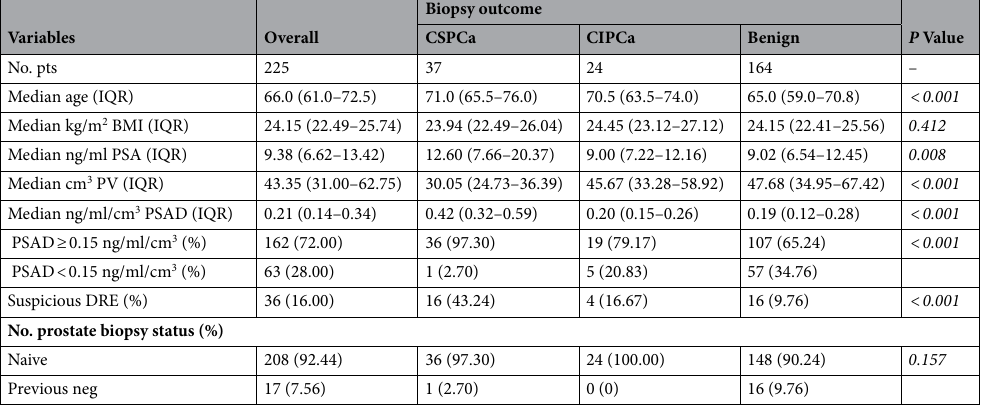
Table 1 listed demographics. Of 208 (92.44%) patients were PB naive and 17 (7.56%) underwent previous nega- tive PB. PB detected PCa in 61 men (27.11%) and CSPCa in 37 (16.44%). Contrast among CSPCa, CIPCa and benign groups showed that prostate-specific antigen (PSA), age, PV, PSA density (PSAD) and suspicious digital rectal examination (DRE) were statistically different among these groups ( P = 0.008, remaining P < 0.001, Table 1, Fig. 2). Comparing 37 patients with CSPCa to 188 with absent CSPCa, univariate analysis showed that a younger absent CSPCa in patients with negative MRI. Furthermore, multivariate analysis authenticated that a younger age ( P = 0.001), greater PV ( P < 0.001), lower PSAD ( P = 0.011) and suspicious DRE ( P = 0.006) were independ- ent predictors of detection of absent CSPCa (Table 2). ROC curve analysis of absent CSPCa detection reveal a larger AUC for PSAD compared to PV or PSA or other parameters (0.8478 vs 0.8084 vs 0.6607, Fig. 3, Table 3). All 57 patients (25.33%) with PSAD less than 0.15 ng/ml/cm 3 and naive biopsy history had no CSPCa on biopsy. (Table 3). The negative predictive value (NPV) of bpMRI for CSPCa detection improved with decreasing PSAD (Table 3 and Fig. 4). The NPV of negative bpMRI increased from 83.56% in all patients to 98.41% in patients with PSAD < 0.15 ng/ml/cm 3 . There was evidently improvement in the NPV of bpMRI in biopsy naive patients from